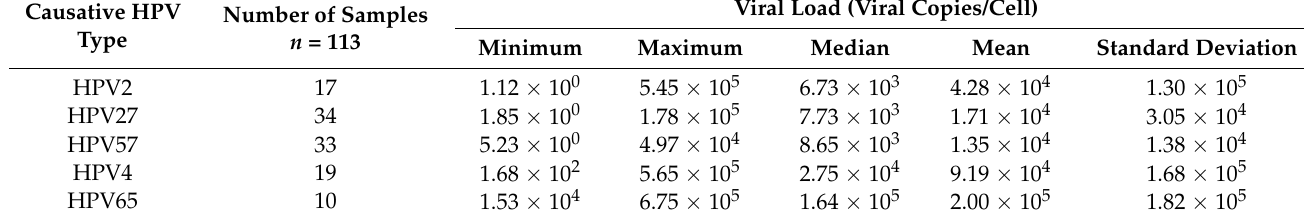
Table 4. Minimum, maximum, median, mean, and standard deviation of estimated cellular vi- ral loads of the five most frequent causative human papillomavirus (HPV) types (HPV2, HPV27, HPV57, HPV4, and HPV65) detected in 113 histologically confirmed common warts obtained from 77 immunocompetent patients.